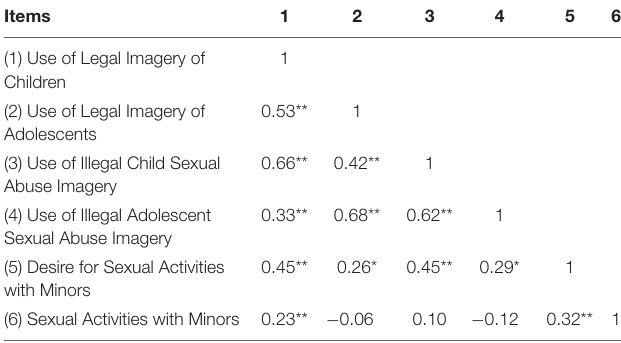
TABLE 2 | Results of Pearson correlation tests for inter-item correlations of the items for frequency of the use of child abuse/exploitation material and frequency of sexual desire/behavior toward children inter-item